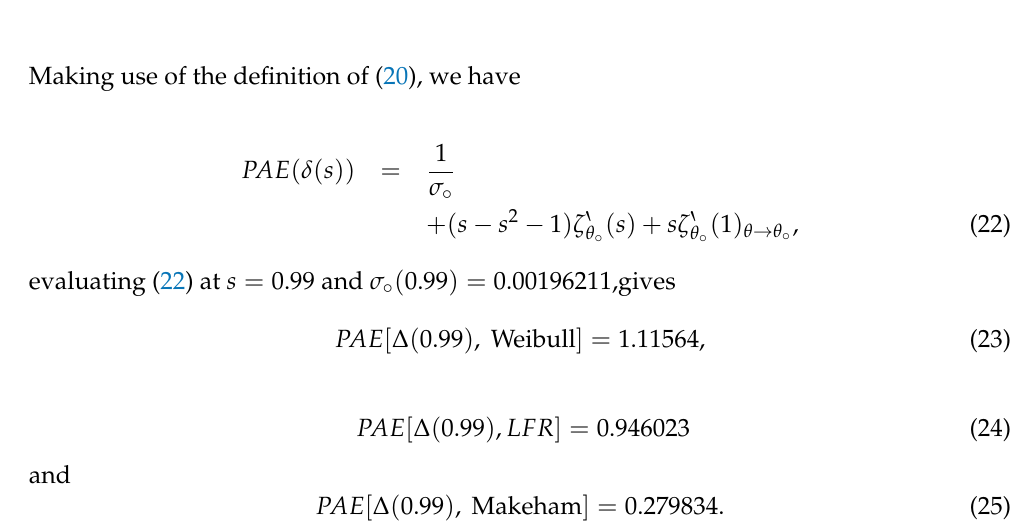
Table 1 indicates a comparison of the proposed PAE test with various other tests based on some probability models. Table 1. Comparison between PAE test and some competitive